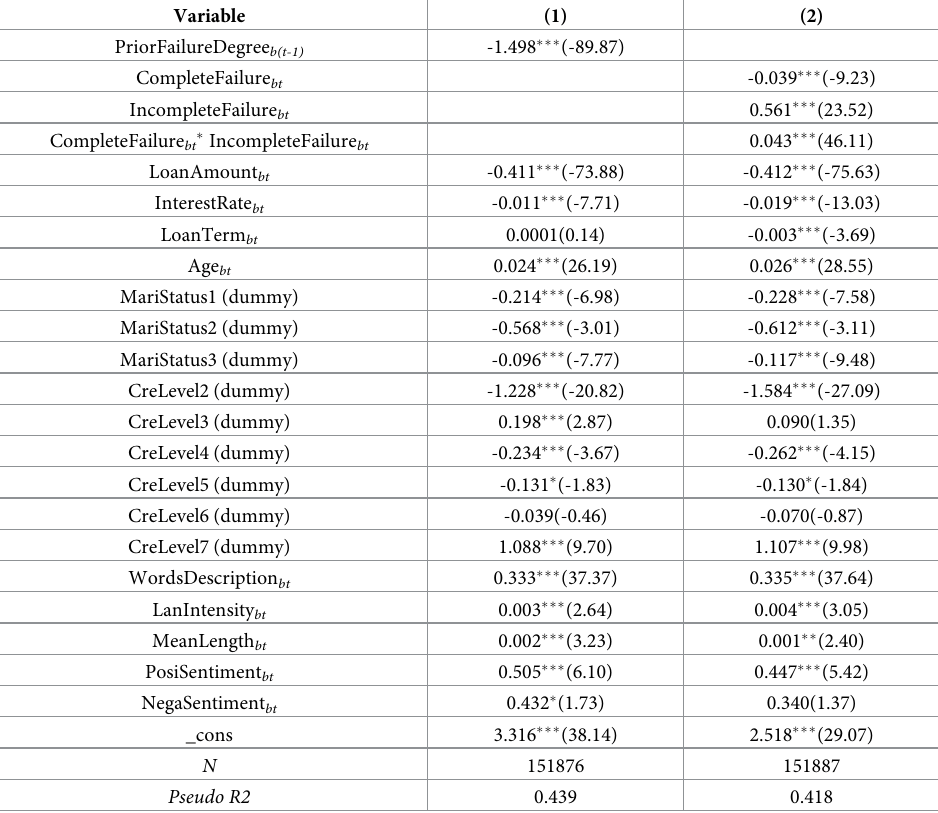
Table 6. The robust probit regression results for the effect of failure degree on funding